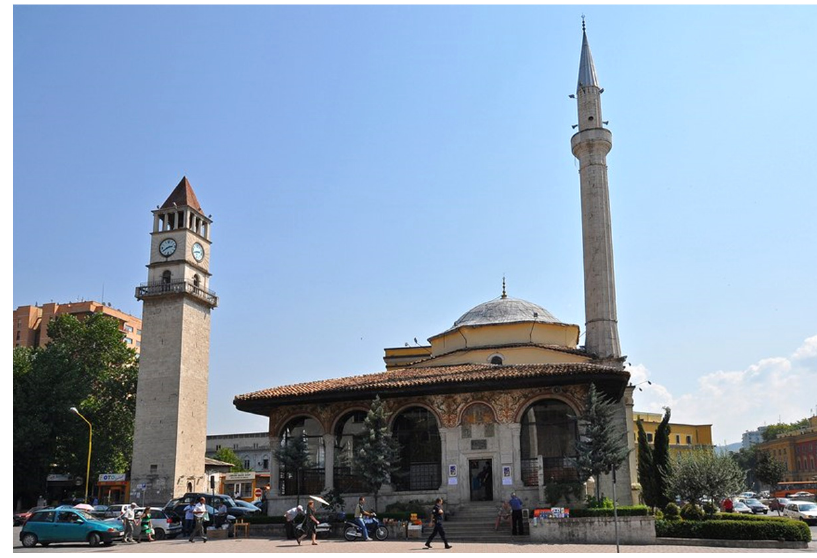
Figure 10. External view of the Et’hem Bey Mosque in Tirana [12].